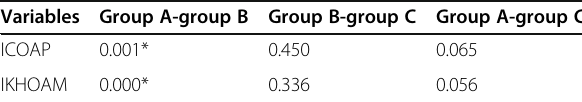
Table 4 Pairwise comparisons of the groups Variables Group A-group B Group B-group C Group A-group C